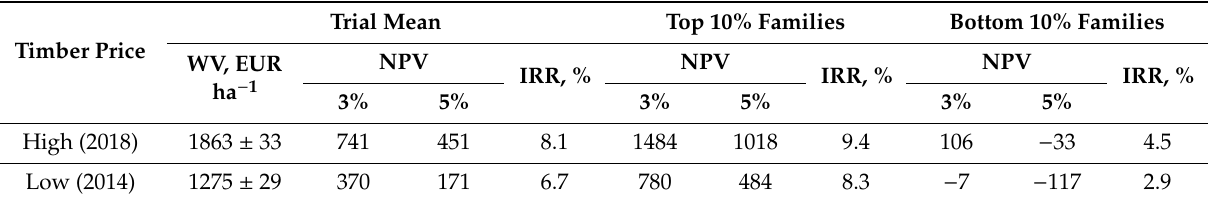
Table 3. The economic indicators of the selected trees of the silver birch trial at the first thinning at the age of 14 years.